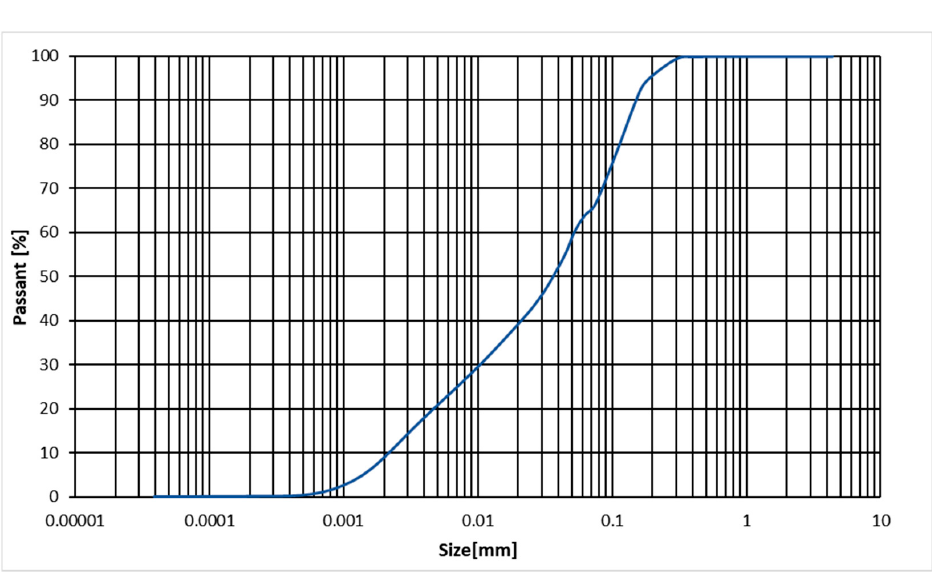
Figure 3. Tailings granulometric curve. Based on Unified Soil Classification System (USCS) classification tests of tailings and their Atterberg limits, the tailings are classified as a low plasticity silt type soil (ML) according to Figure 4, which is an inorganic silt with low compressibility.